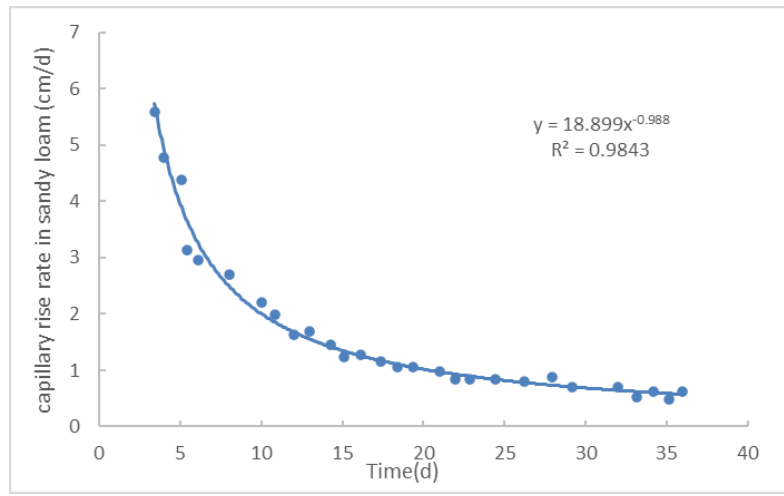
Figure 9. Variation curve of capillary rise rate in the loam soil.